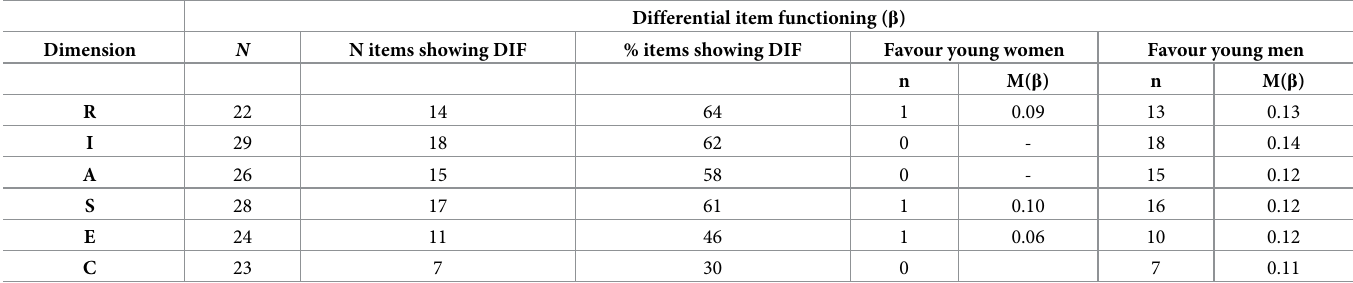
Table 6. Number and percentage of items showing